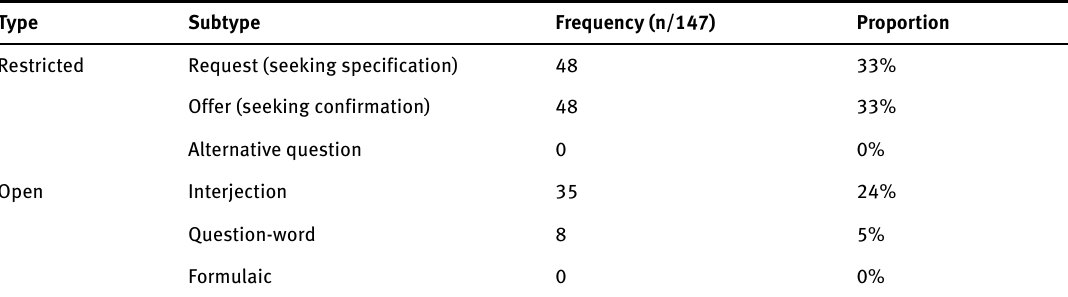
Table 3: Types of repair initiators and their frequency in the Murrinh-Patha